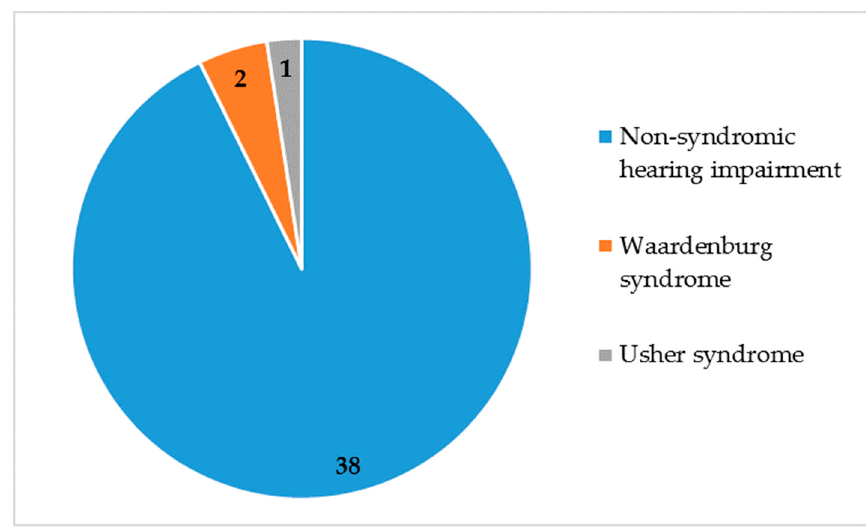
Figure 1. Non-syndromic and syndromic hearing impairment. N = 41 families Figure 2. Non-syndromic and syndromic hearing impairment. N = 41 families. Four patients from two families in our cohort presented type 2 Waardenburg syndrome (without dystopia canthorum). The main clinical signs included: hearing impairment, patches of hypopigmented skin, sapphire-blue eyes, and premature white hair (Figure 3).